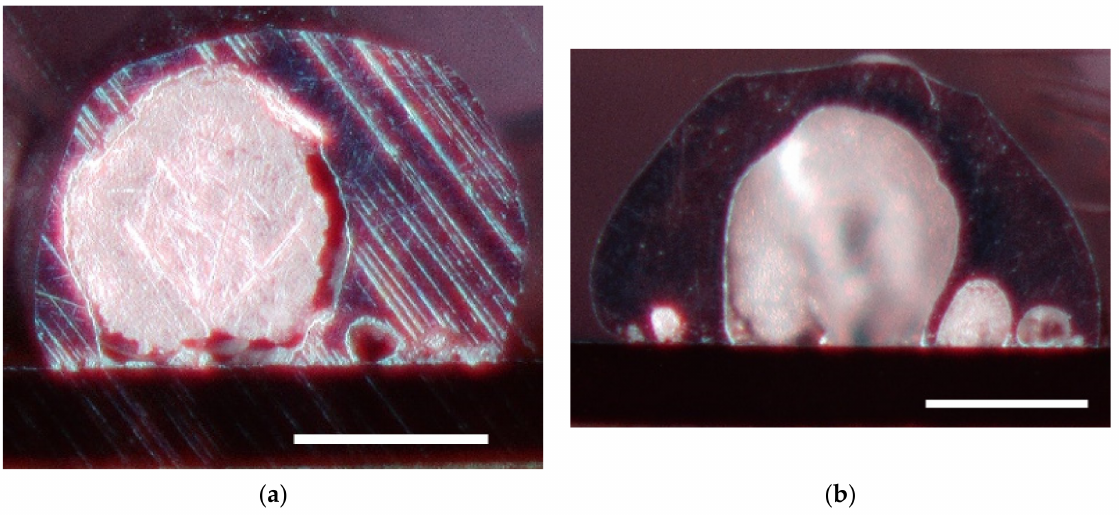
Figure 12. Pinholes in ( a ) undried and ( b ) dried substrate. Scale bar = 250 µ